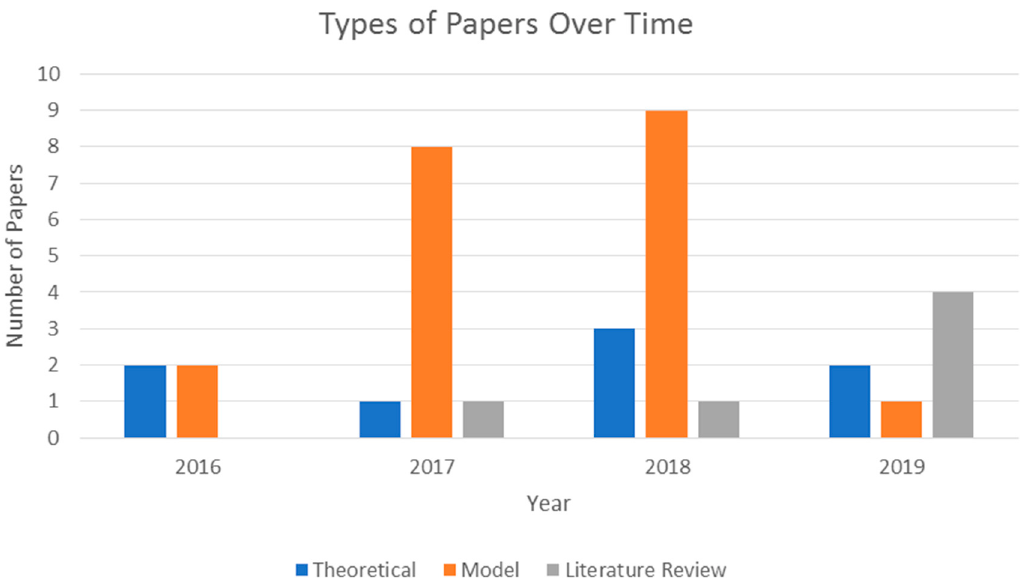
Figure 4. Types of papers published over time.